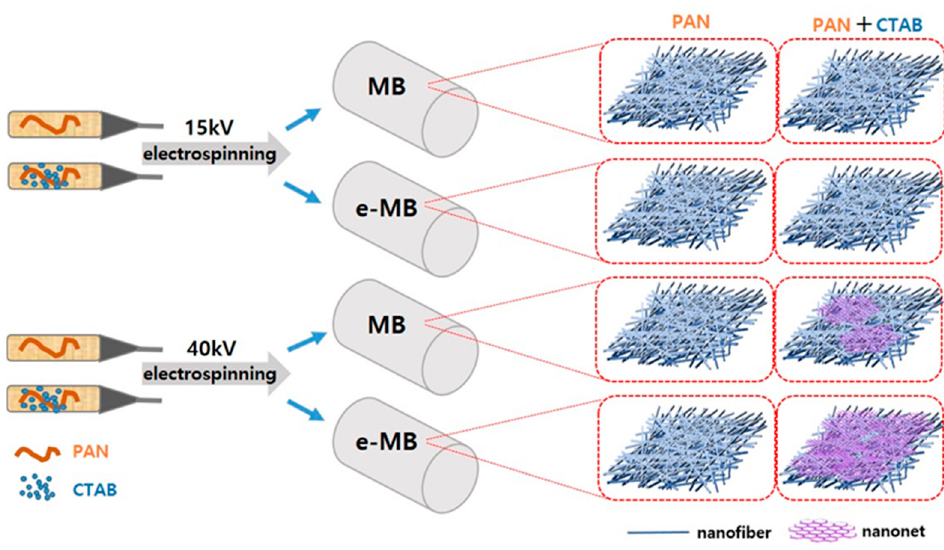
Figure 1. Schematic of the fabrication of PAN–CTAB nanofiber/nanonet web on electrostatically treated meltblown (e-MB) and discharged MB nonwoven filter.